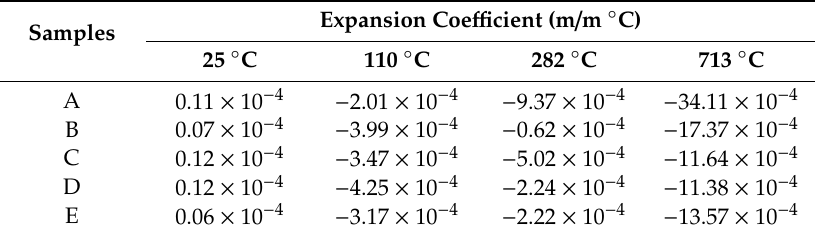
Table 4. The expansion coefficient of the scaffold from TMA measurement.